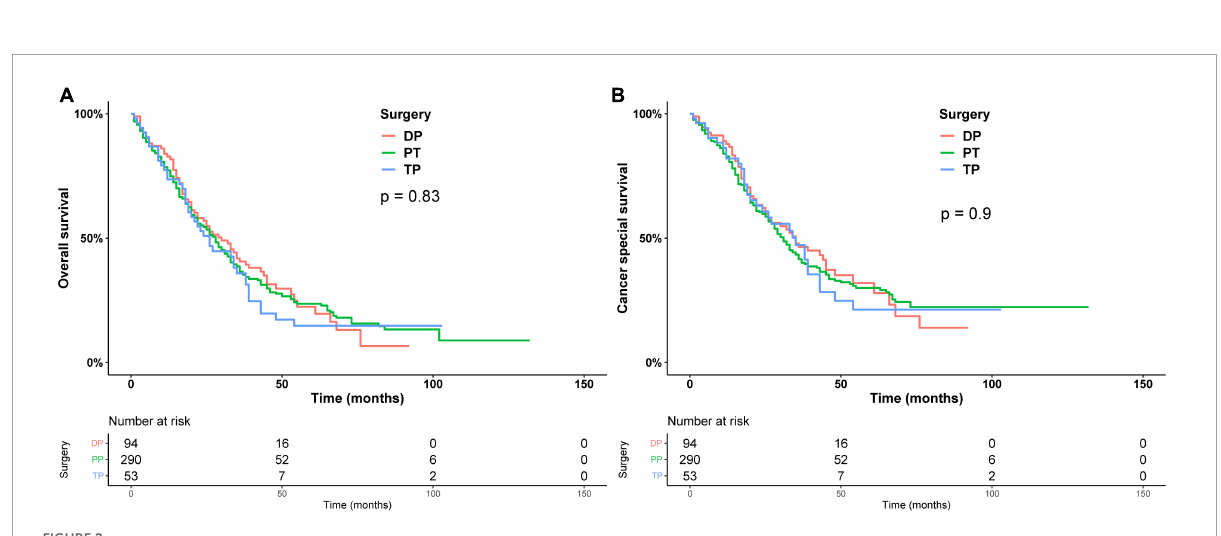
FIGURE2 Kaplan–Meier analysis of overall survival (A) and cancer-specific survival (B) of different types of